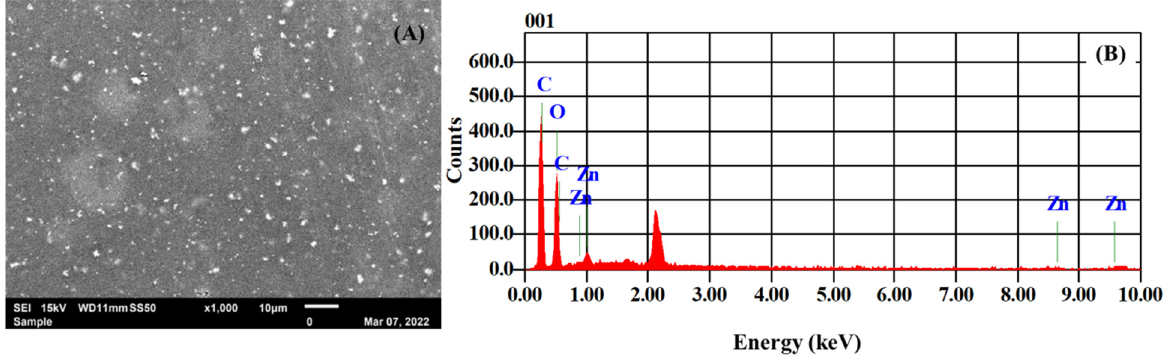
Figure 4. ( A ). SEM image of ZnO/PVA/IL membrane. ( B ) EDX spectrum of ZnO/PVA/IL membrane.